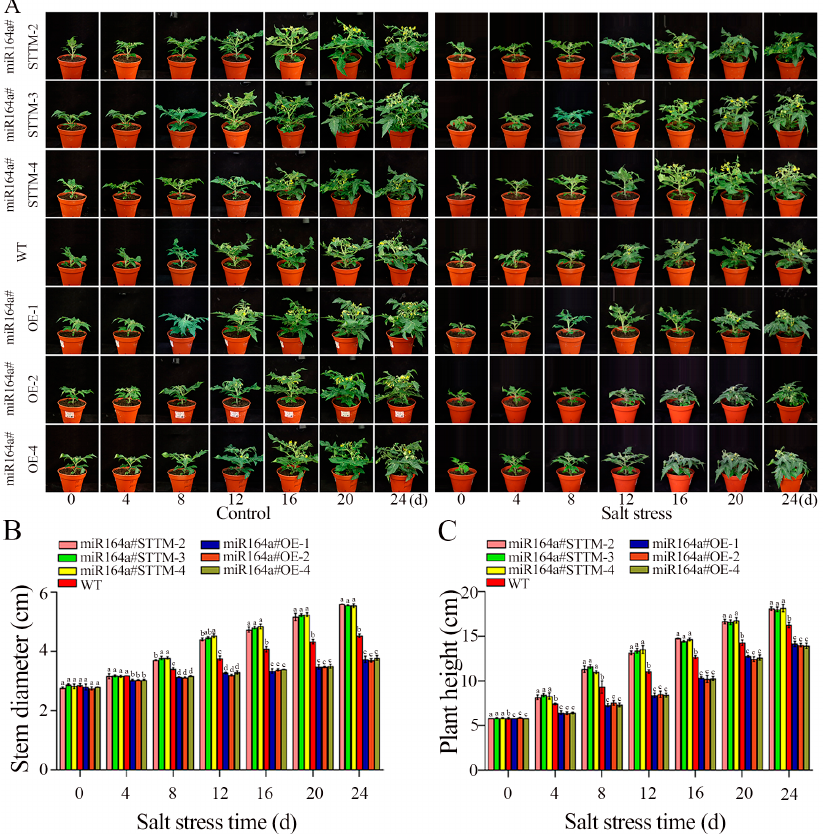
Figure 3. The growth of miR164a#STTM, WT and miR164a#OE tomato seedlings under control and salt stress. ( A ) Growth of miR164a#STTM, WT and miR164a#OE tomato seedlings under salt treatment for 24 days. ( B ) Stem diameter variation of miR164a#STTM, WT and miR164a#OE tomato seedlings under salt treatment. ( C ) Plant height variation of miR164a#STTM, WT and miR164a#OE tomato seedlings under salt treatment. Vertical bars represent standard deviations of the means, n = 3. Different letters indicated significant differences between WT and transgenic tomatoes in the values at p < 0.05.